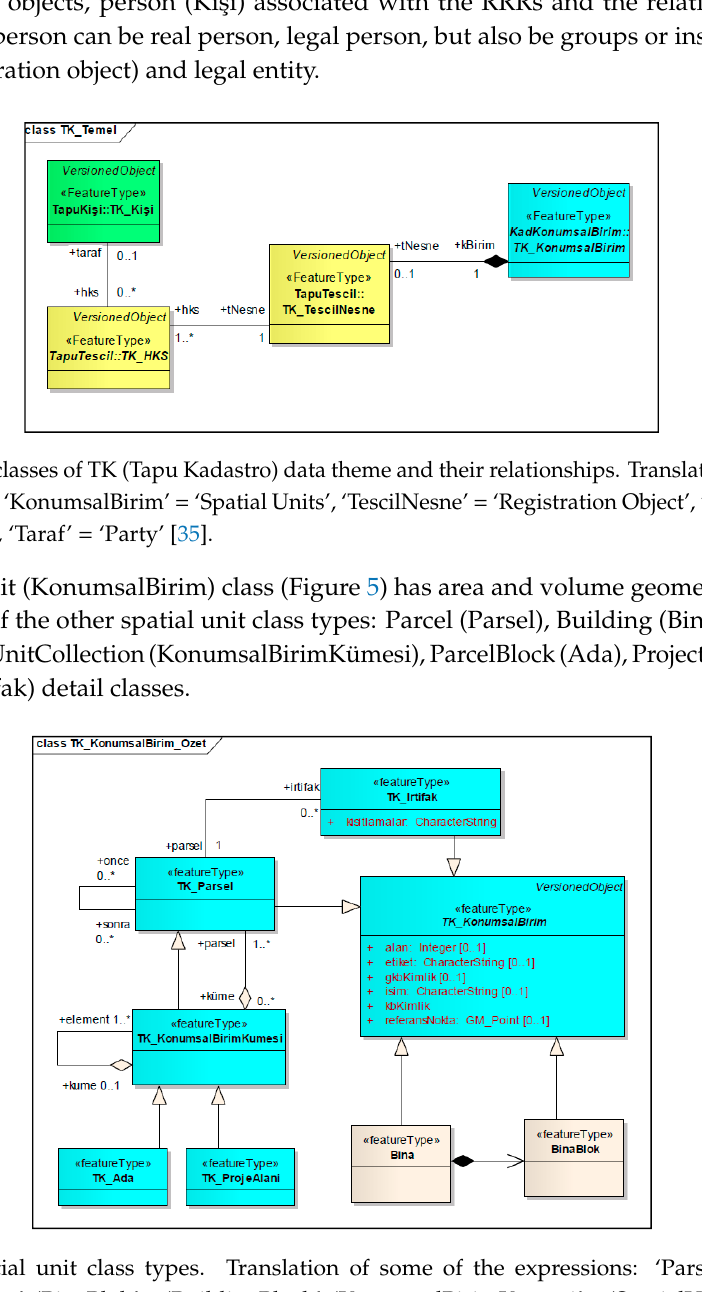
Figure 6. Individual unit class in relation with building and building block classes. Translation of some of the expressions: ‘Bina’ = ‘Building’, ‘BinaBlok’ = ‘BuildingBlock’, ‘BagimsizBolum’ = ‘IndividualUnit’, ‘KonumsalBirimKümesi’ = ‘SpatialUnitCollection’, ‘Parsel’ = ‘Parcel’, ‘KonumsalBirim’ = ‘SpatialUnit’ [37].